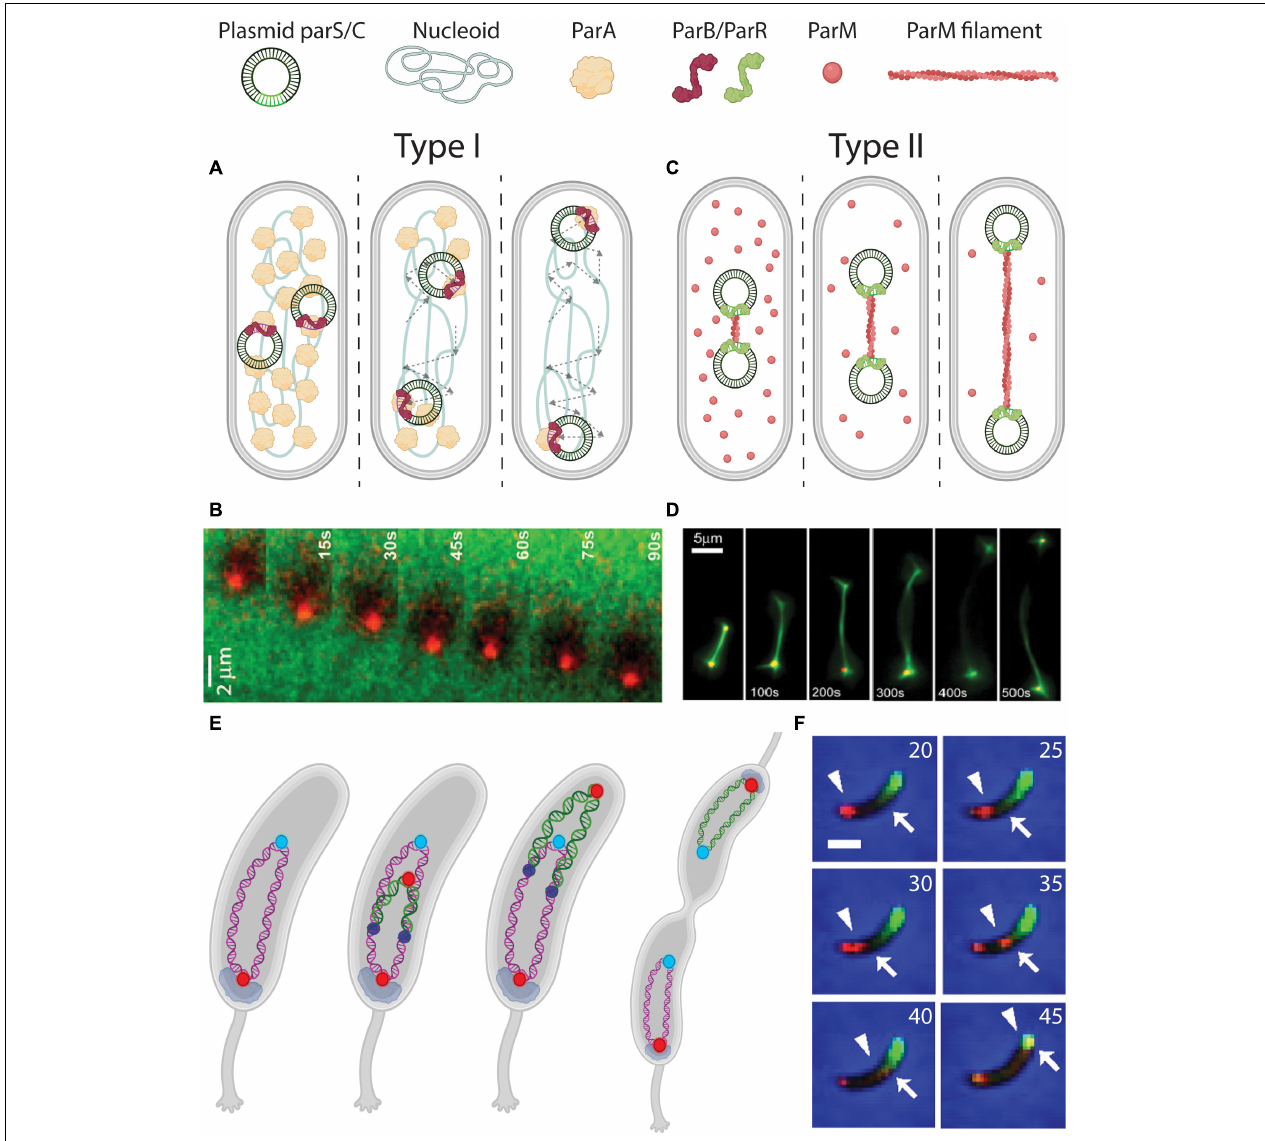
FIGURE 4 | DNA segregation by pushing and pulling. (A) Pulling mechanism for plasmid segregation by parABS (Type I). parS sequences on the plasmids are bound by ParB (red signal and arrowhead). The ParB- parS nucleoprotein then moves outward, with its attached plasmid, through interactions with ParA (green signal and arrow) that is localized between ParB- parS and the poles. Dashed arrows indicate the traversed path of the plasmids. (B) Fluorescence time-lapse imaging of ParB (red) moving over a ParA carpet (green). From Vecchiarelli et al. (2014). (C) Pushing mechanism for plasmid segregation by ParMRC (Type II). parC sequences on the plasmids are bound by ParR (green). In between the ParR- parC nucleoprotein of a pair of plasmids, a ParM (red) filament polymerizes from soluble monomers, to push the plasmids apart toward the poles. (D) Fluorescence time-lapse imaging revealing the in vitro growing ParM filament between a pair of plasmids. From Garner et al. (2007). (E) Chromosome segregation in Caulobacter crescentus bacteria. Before replication, ori (red) is anchored at the old pole by PopZ (gray). After replication initiation (replisomes shown as dark blue circles), one sister ori is pulled over the chromosome toward the new pole. (F) Fluorescence time-lapse imaging of parABS-mediated chromosome segregation in C. crescentus coexpressing mCherry-ParB (red) and GFP-ParA (green). The ori-proximal ParB that is initially localized at the old pole (indicated by an arrowhead) is duplicated and moves over the ParA gradient (edge indicated by an arrow), depleting it in the process. Scale bar 1 µ m. Time is indicated in minutes. From Shebelut et al.